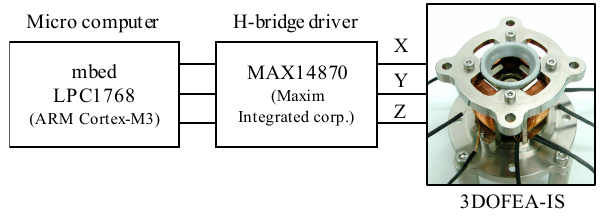
Figure 8. System configuration for the operating verification.